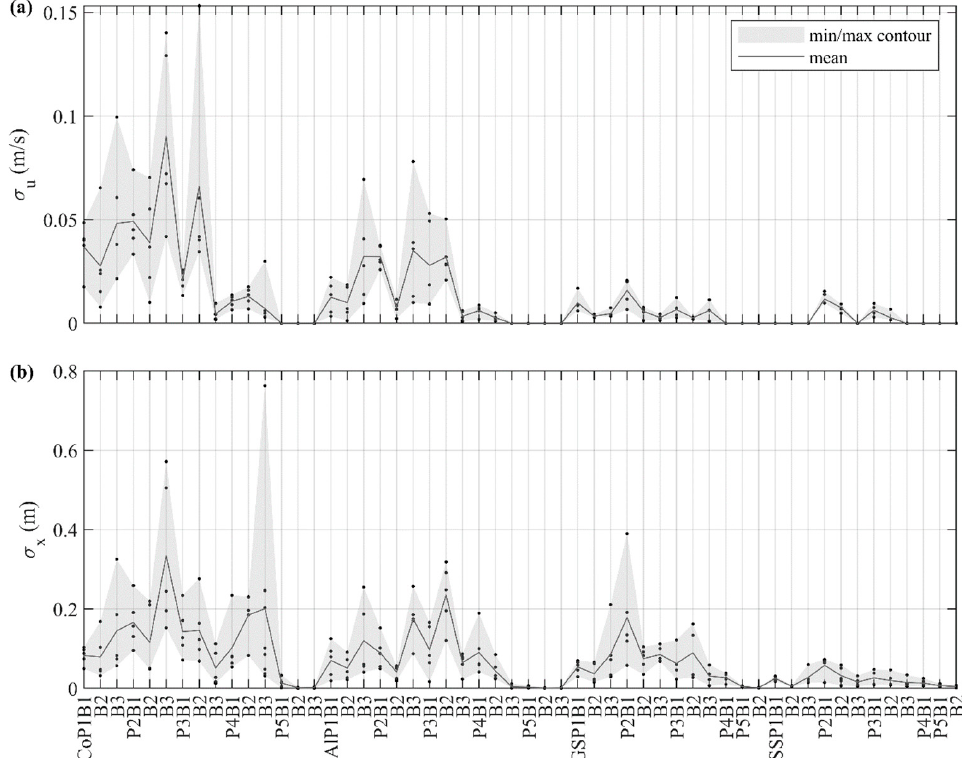
Figure 4. Standard deviations of velocity ( a ) and distance travelled ( b ) for each scenario. Black circles indicate the standard deviations for individual